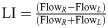
The device data reflected nasal obstruction.(A) Time Series of MRI scans showing the nasal turbinates. Time measured from application of Otrivin (0.1% Xylometazoline Hcl) to the right nostril. Note right nostril decongestion over time. (B) Larger image of nasal passage. (C) Airflow measured in right nostril. (D) Airflow measured in left nostril. (E) Laterality index calculated as: LI=(FlowR−FlowL)(FlowR+FlowL). (F) Airflow in one subject with flipping of left and right nasal cannulas every 1.5 minutes. One logger channel in red and one in blue.